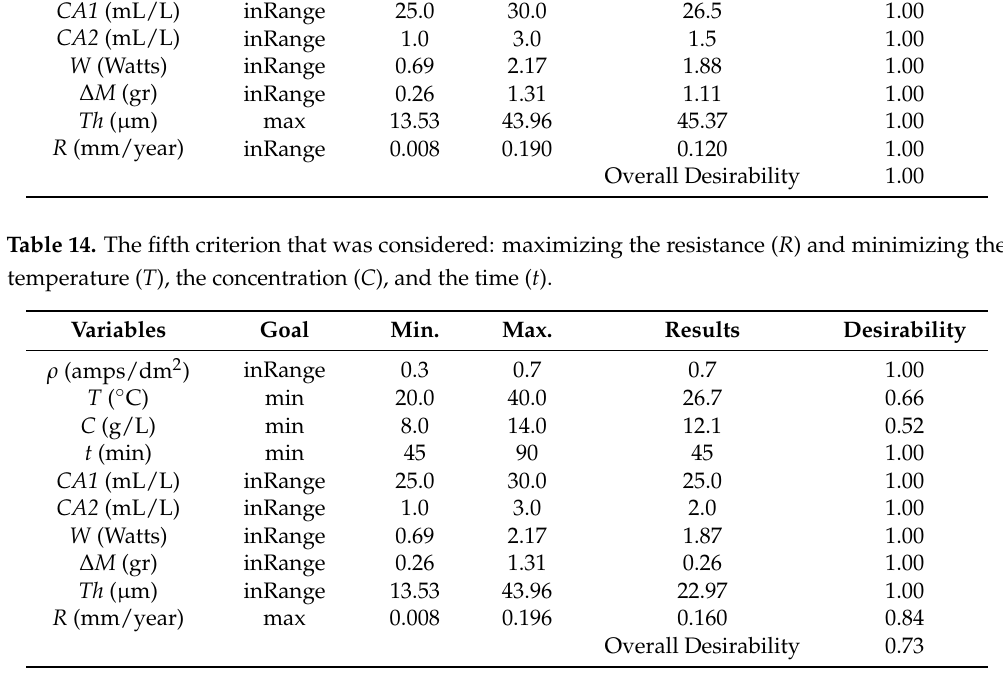
Table 15. The sixth criterion that was considered: maximizing the thickness ( Th ) while minimizing the temperature ( T ), the concentration ( C ), and the time ( t ). Variables Goal Min.